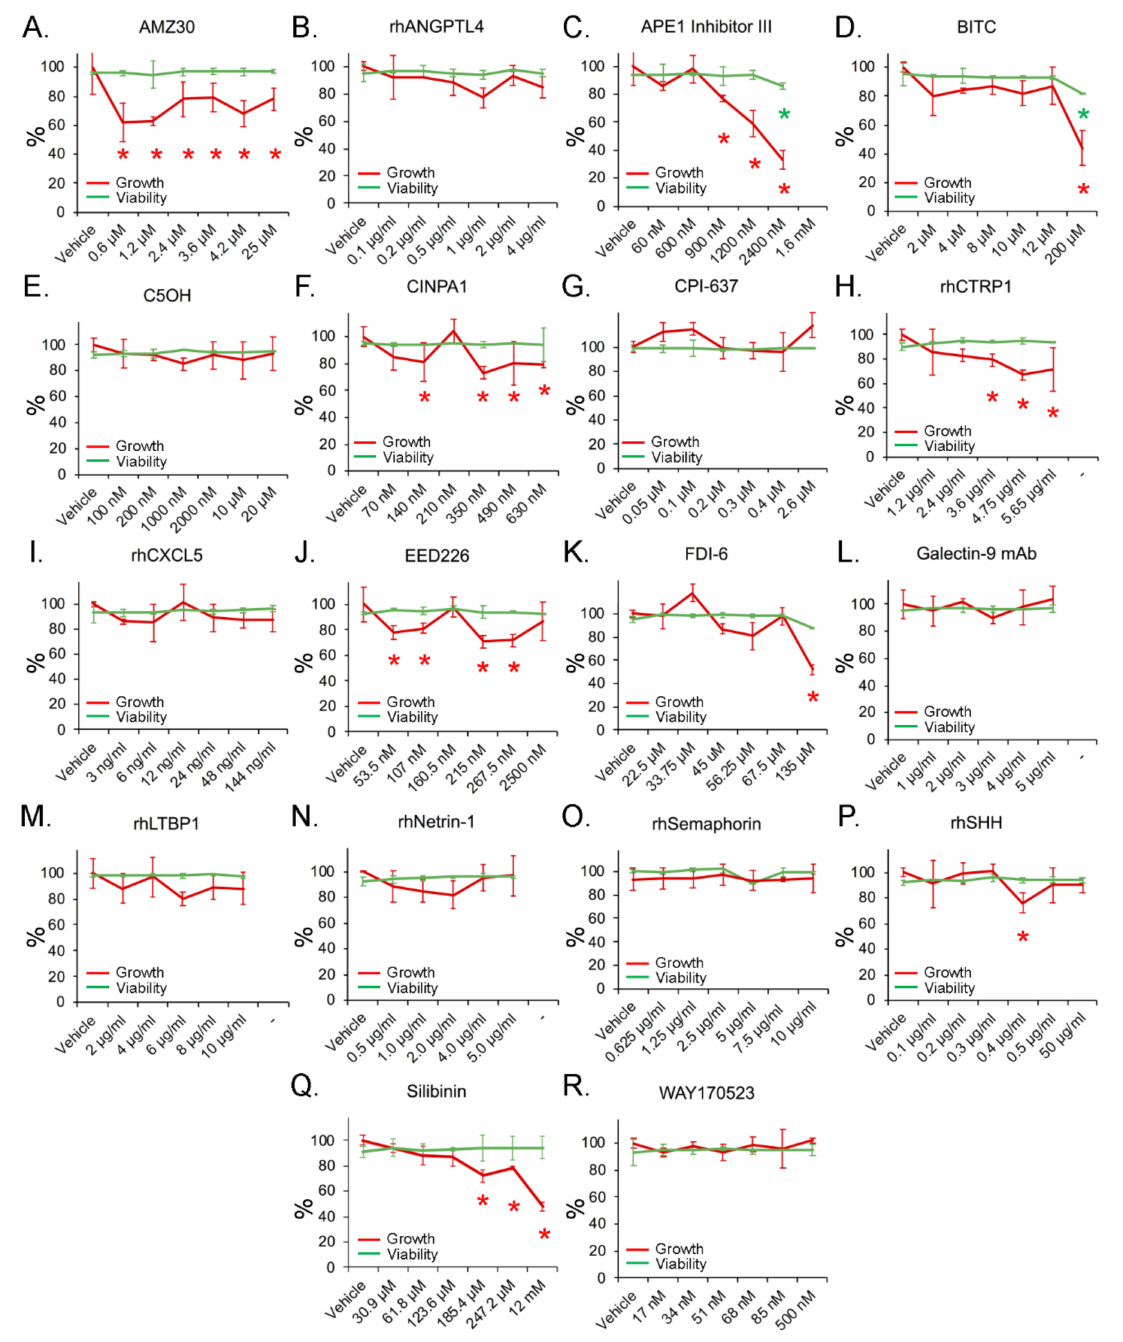
Figure 3. Cell growth and viability screen of compound-treated 786-O cells cultured for three days. ( A – R ) cells treated with compounds at doses specified on x -axis. Percentage growth (red line) was calculated based on the average number of Hoechst 33342 + cells in each condition. Percentage viability (green line) was calculated based on the average proportion of Ethidium Homodimer-1 positive nuclei to negative nuclei. Color matched asterisks indicate significance compared to vehicle control, as determined by a Student’s t